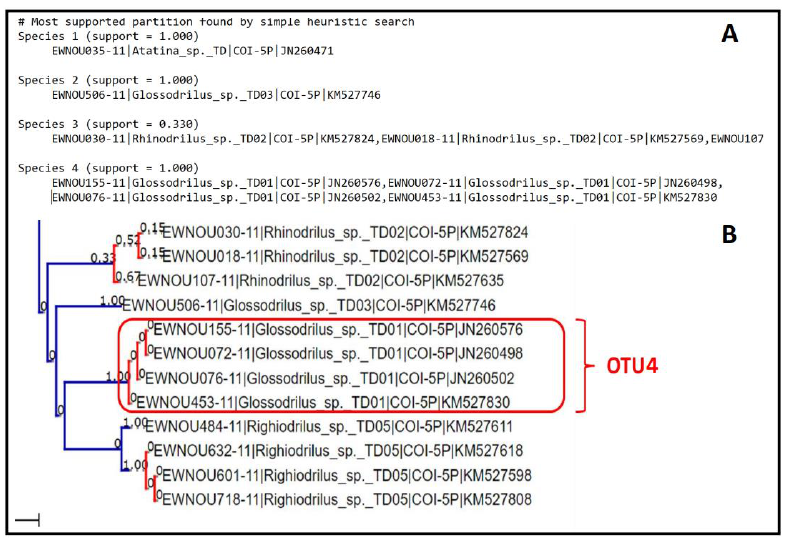
Figure 1. Output results obtained with the PTP method: ( A ) extract from the text file showing the distribution of sequences from dataset 1 in the different OTUs; ( B ) extract from the output phyloge- netic tree showing the distances between sequences and how they are distributed in the different OTUs. GMYC only provides a phylogenetic tree with a color-coded system on the terminal branches to visualise OTUs; only singletons appear in black in this tree (Figure 2A). Note that the graphical quality is not optimized, and it is therefore necessary to return to the input tree, which has the same topology, in order to interpret the groupings of sequences into OTUs. As no text output is provided, it is necessary to manually transfer the OTU assignments into a spreadsheet so that they are available for further analysis. Figure 2. Output results obtained with the GMYC method: ( A ) extract of the output tree of the GMYC method in which the color codes allow the visualisation of OTUs delimitations; ( B ) extract